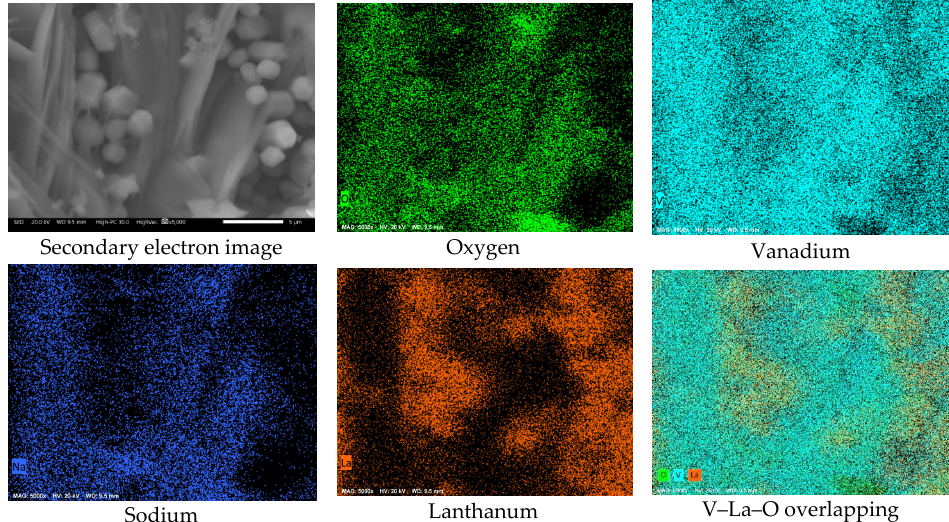
Figure 11. Cross-sectional aspect and element mapping of the 304H steel interface corroded in NaVO 3 with 10% La 2 O 3 at 900 °C after 100 h.